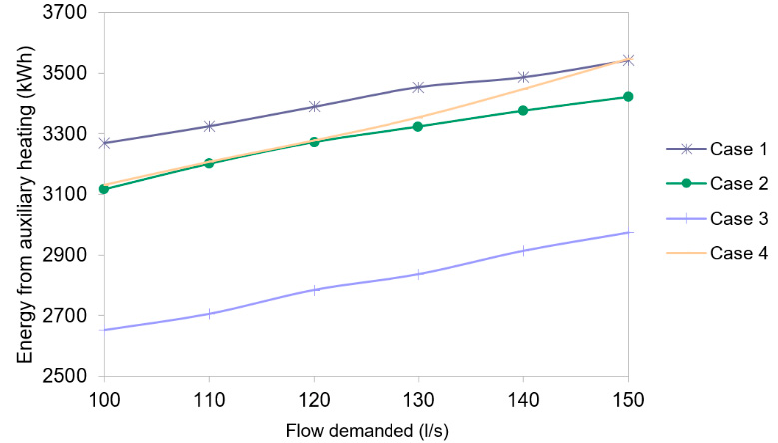
Figure 5. Energy from auxiliary heating in Cases 1–4.